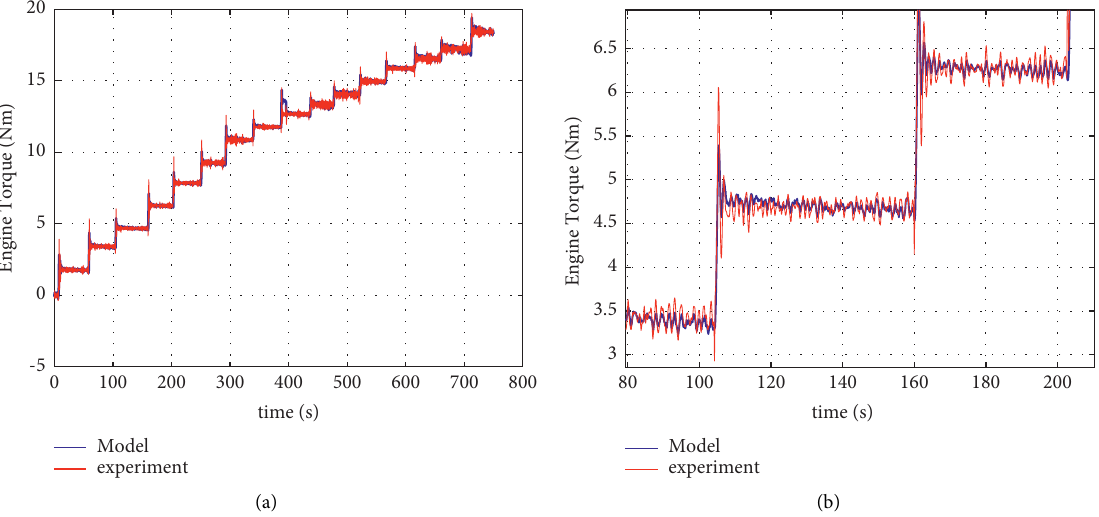
Figure 15: Torque simulation results. (a) Torque results in loading process. (b) Torque results during 80 s to